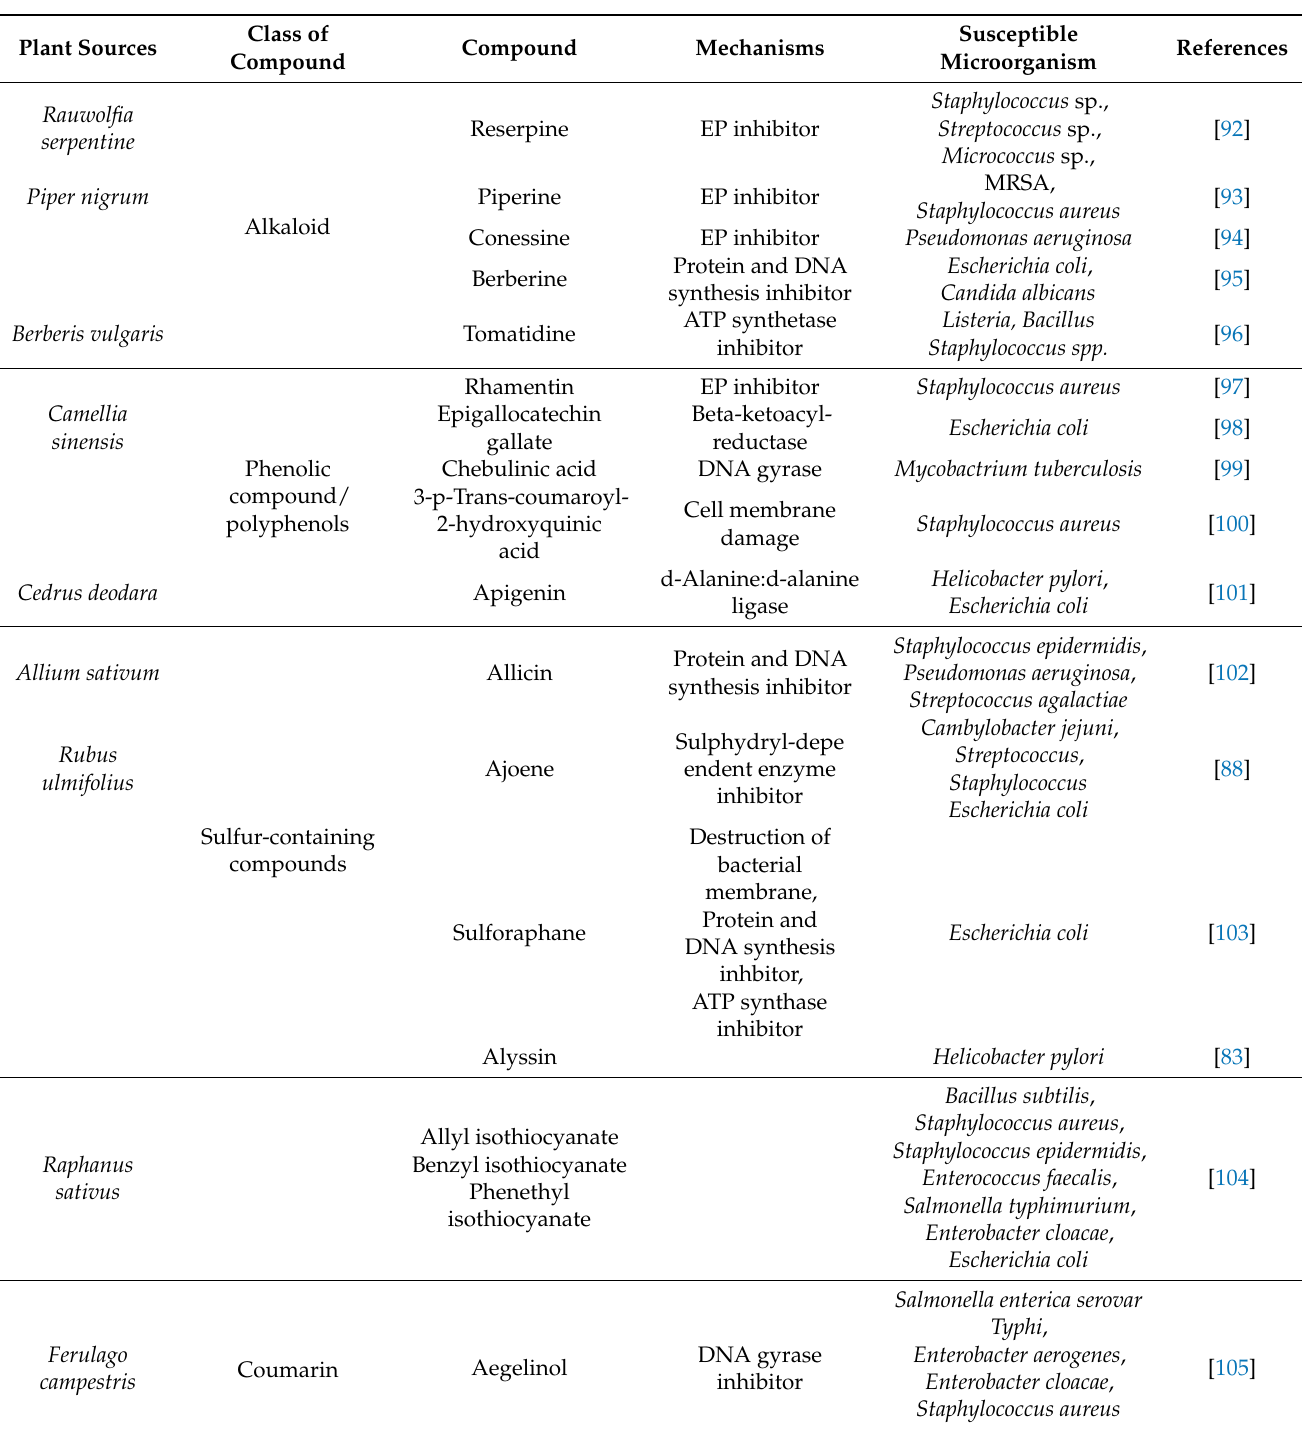
Table 1. Some important medicinal plant extracts compounds with antimicrobial